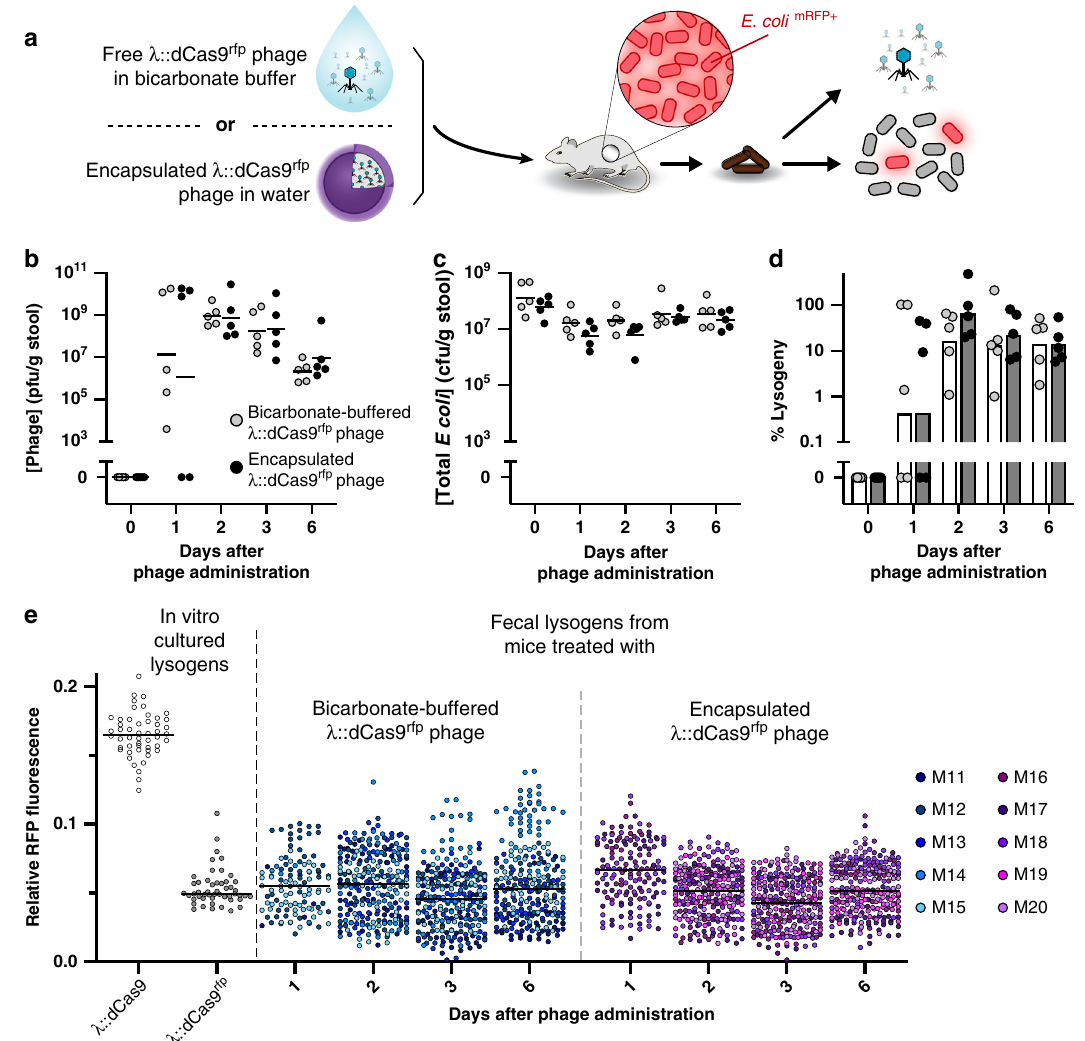
Fig. 6 Encapsulation protects oral phage but does not impair function. Free λ ::dCas9 rfp phage in bicarbonate buffer (to ensure survival) or encapsulated λ ::dCas9 rfp phage in water were orally administered to mice pre-colonized with E. coli expressing RFP and GFP ( a ). After oral administration, fecal phage ( b ), total E. coli ( c ), and percentage of E. coli lysogenized by phage were quanti fi ed ( d ). Symbols represent individual mice ( n = 5) with bars or lines indicating the geometric mean. Ensemble view of relative fl uorescence from lysogens shown with in vitro-cultured controls ( e ). Symbols represent 50 individual colonies per mouse per sample or the maximum discernable colonies (Mouse 1, Day 1 = 5 colonies; M13, D1 = 0; M14, D1 = 8, D6 = 49; M15, D1 = 49; M19, D1 = 0; M20, D1 = 0) with lines indicating the median. Source data are provided as a Source Data fi E. coli concentration (Fig. 6c), lysogenic conversion of fecal E. coli (Fig. 6d), and ratio of fecal phage to E. coli (Supplementary Fig. 15). When examining the relative RFP fl uorescence of indi- vidual λ ::dCas9 rfp lysogen colonies, both buffered and encapsu- lated phage provided similar levels of RFP repression for the duration of the study (Fig. 6e).